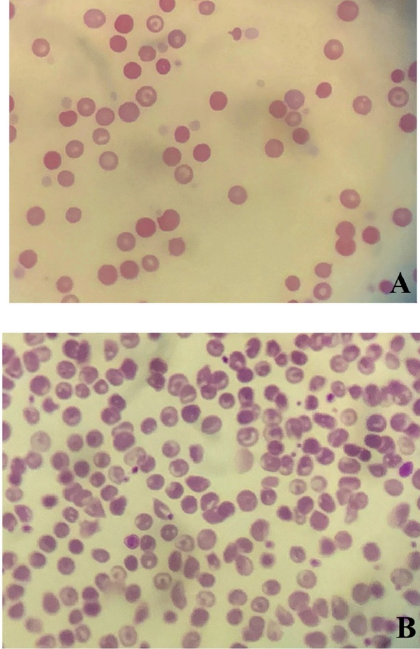
Figure 1. Blood smear findings (original magnification, 40 × ). ( A ) Mild anisocytosis, along with polychromatic erythrocytes and spherocytosis, were observed (initial clinical visit). ( B ) Codocytes were observed but no spherocytes were observed (day